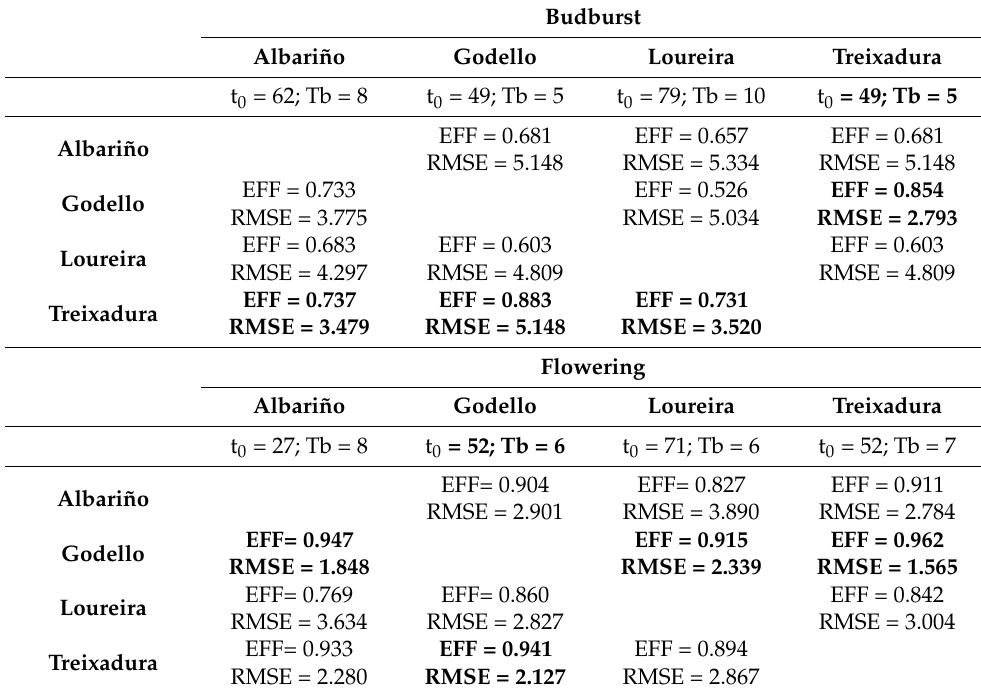
Table 2. Goodness-of-fit indicators for the GDD model per each variety for estimation and validation process using the dataset for each other’s grapevine varieties. Fitted of t 0 : day of the year and Tb: base temperature. Bold letters show the best performing models for each variety and phenological phase.